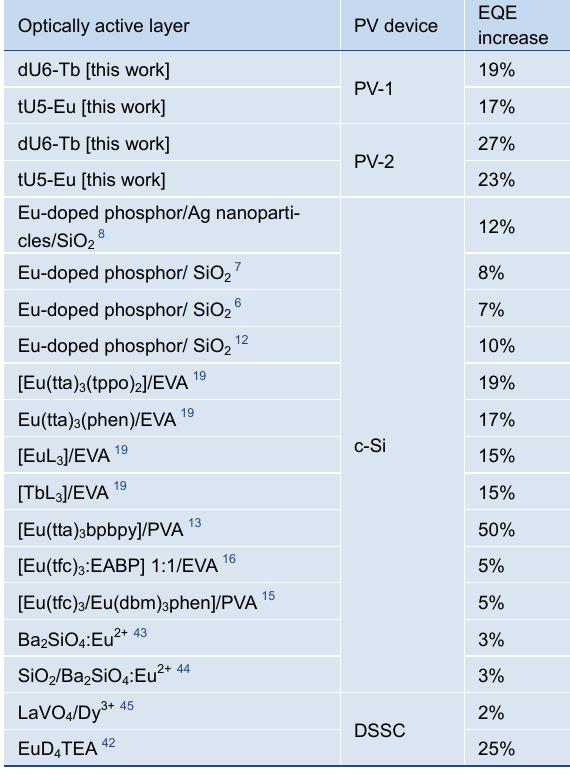
Table 1 | Reported absolute EQE increase in the UV spectral region for Ln 3+ -based LDS coatings. Optically active layer